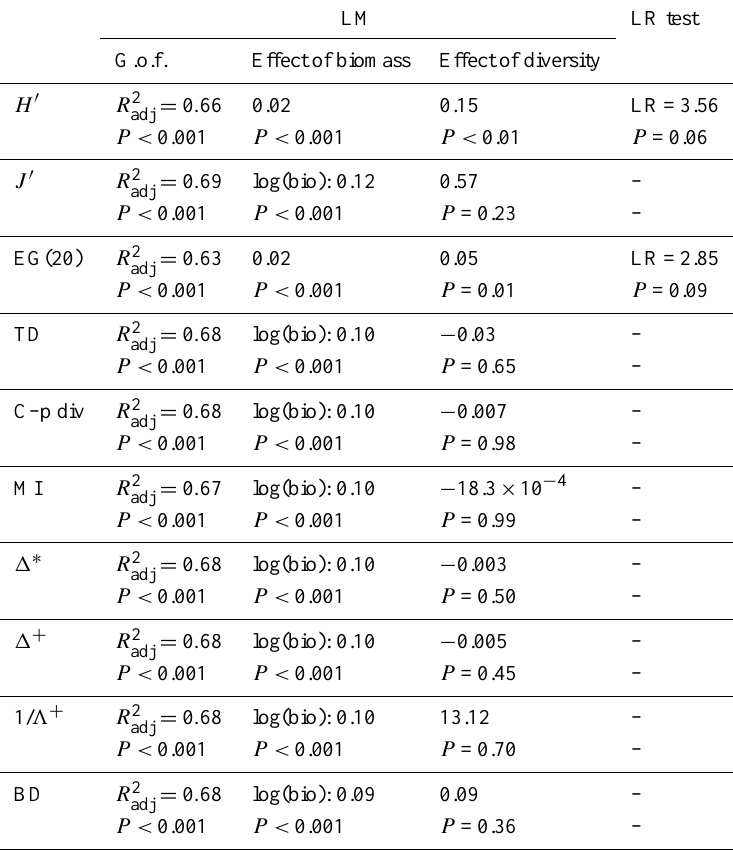
Table 5. Results of linear models (LM), and the likelihood ratio (LR) test for the regression of nematode diversity and total nematode biomass against total respiration. Since the LR test was never significant, only the LM results were interpreted. The estimated average size of the effect and the associated P value are given for biomass and each diversity index. Except for the regressions with H 0 and EG(20), biomass (bio) was log e transformed to comply with the assumptions of linear regression. H 0 : Shannon–Wiener diversity, EG(20): expected genus richness for a sample of 20 individuals, J 0 : Pielou’s evenness, TD: trophic diversity, c–p diversity: diversity of c–p (life history) classes, MI: maturity index, 1 + : average taxonomic distinctness based on presence–absence data, 1 ∗ : average taxonomic distinctness based on quantitative data, 1/ 3 + : taxonomic evenness, BD: biomass diversity, R 2 : adjusted R 2 , R 2 m : marginal R 2 , and G.o.f.: goodness of adj